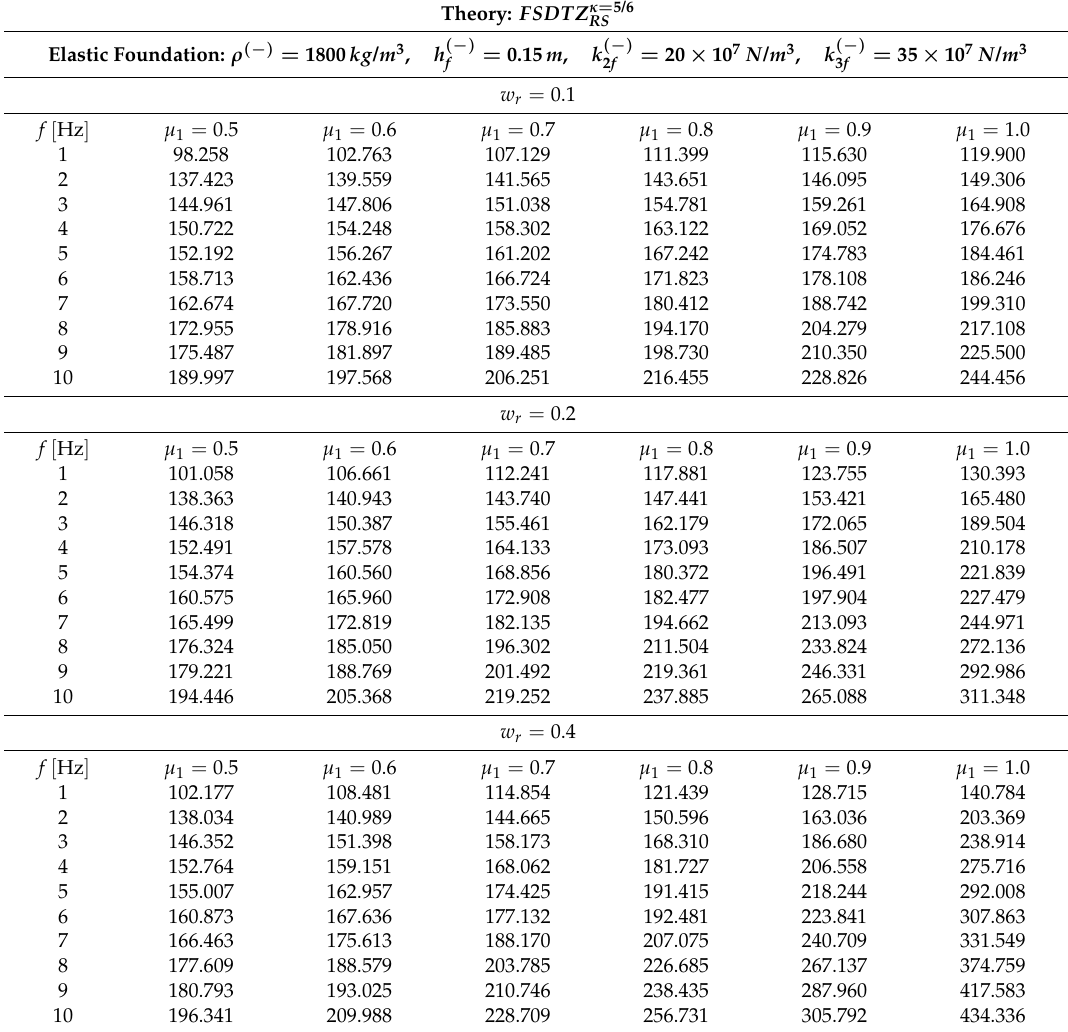
Table 10. First ten natural frequency variations for FSDTZ κ = 5/6 RS (Figure 4c) reinforced by CNTs distributed as in Figure 5c for different mass fractions w r when varying the parameter of agglomeration µ 1 with µ 2 = 1. The Chebyshev-Gauss-Lobatto grid distribution was employed, with I N = 31, I M =